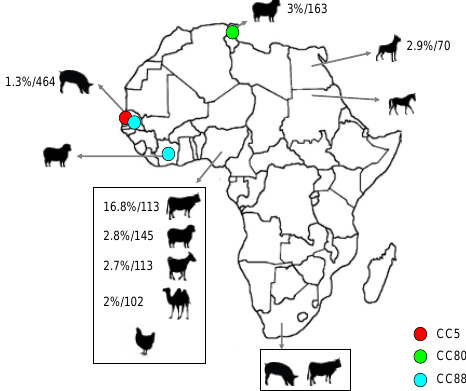
Figure 2. Animal species, clonal lineages and prevalence of MRSA identified in the Africa continent. Prevalence (%) is calculated considering the total number of samples of each animal species included in the different studies and is indicated when this estimation is possible with the data shown in each publication. Moreover, in those cases, the number of samples studied is also indicated (%/number of samples). The clonal complexes were determined by e-BURST when sequence types were indicated in the study and were presumptively assumed according to the spa -types when the sequences types were not indicated in the